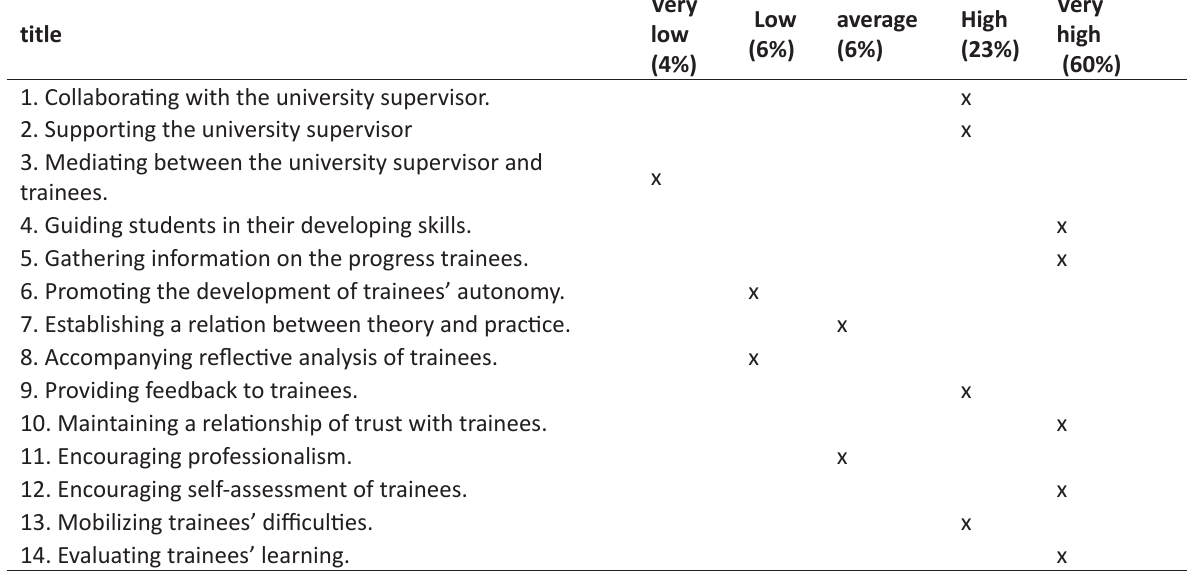
Table 3. Degree of importance of cooperative teacher